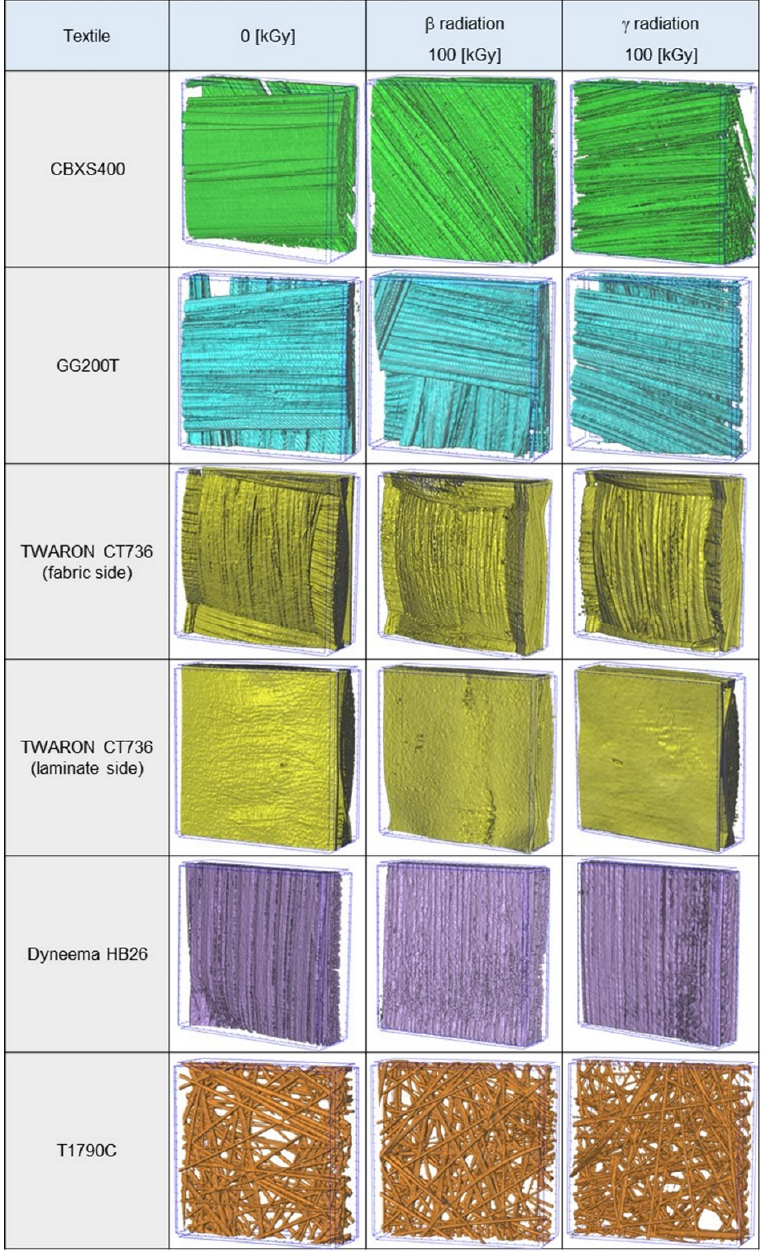
Figure 11. Three-dimensional micro-computed tomography reconstructions of unmodified and